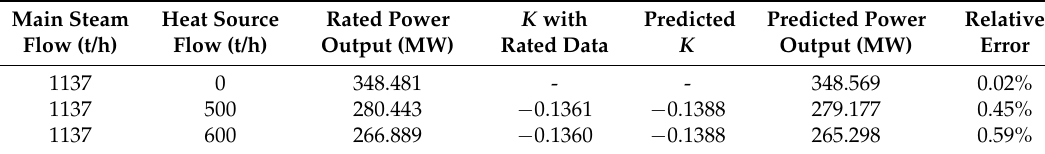
Table 1. Calculation results on a 330 MW